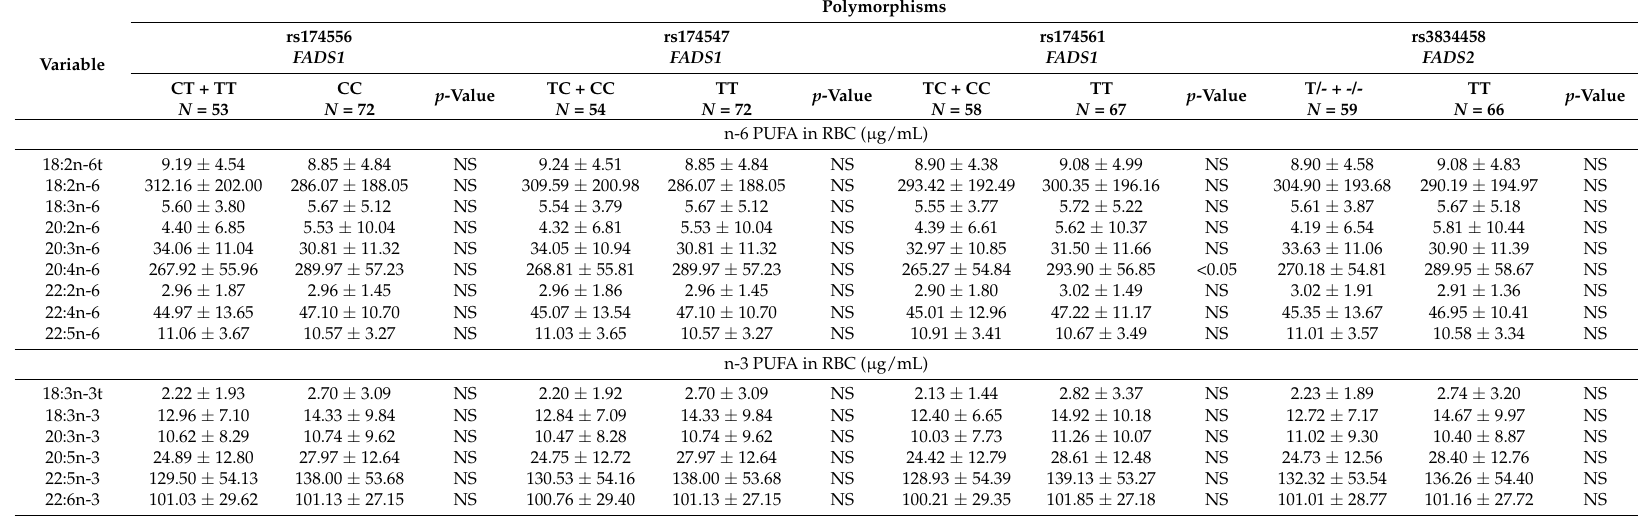
Table 4. Associations between FADS1 and FADS2 polymorphisms and fatty acid concentrations in erythrocyte membranes.